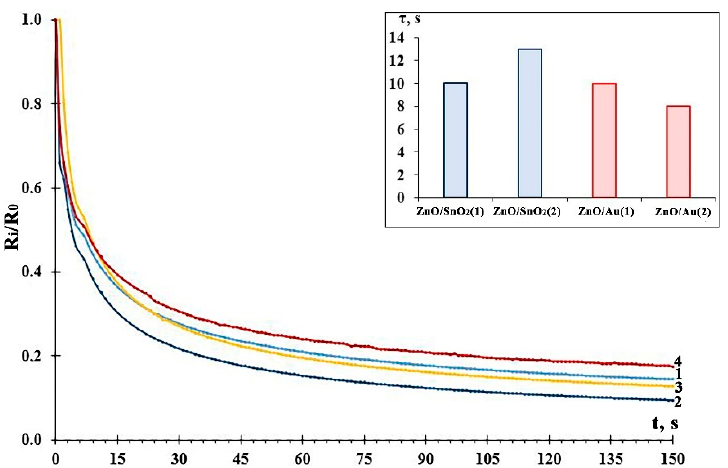
Figure 5. The kinetics of resistance of four sensor samples: (1) ZnO/SnO 2 (1), (2) ZnO/SnO 2 (2), (3) ZnO/Au(1) and (4) ZnO/Au(2) NRs, inserting plots of the constants of photoconductivity relaxation time, τ , for various samples.